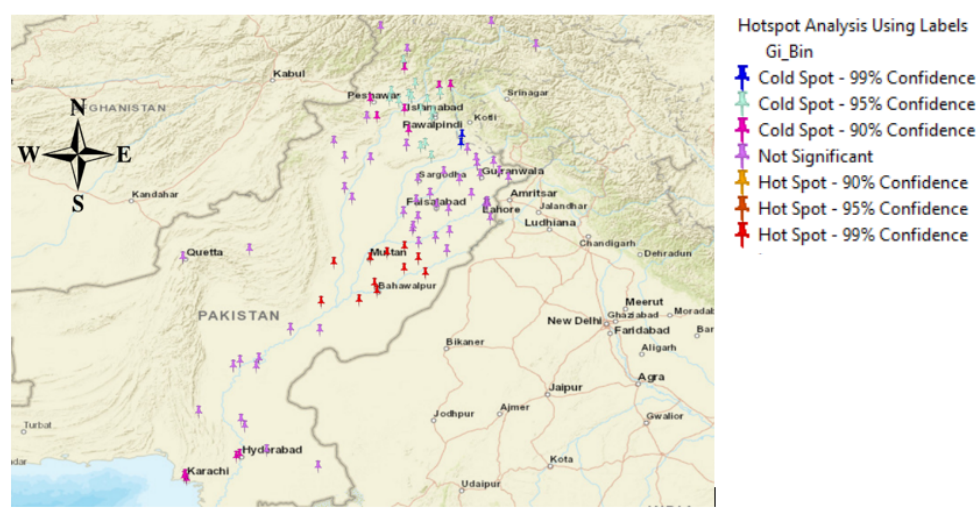
Figure 10. Visualization of hotspot analysis of tweets’ labels over Pakistan’s base map Using ArcGIS.